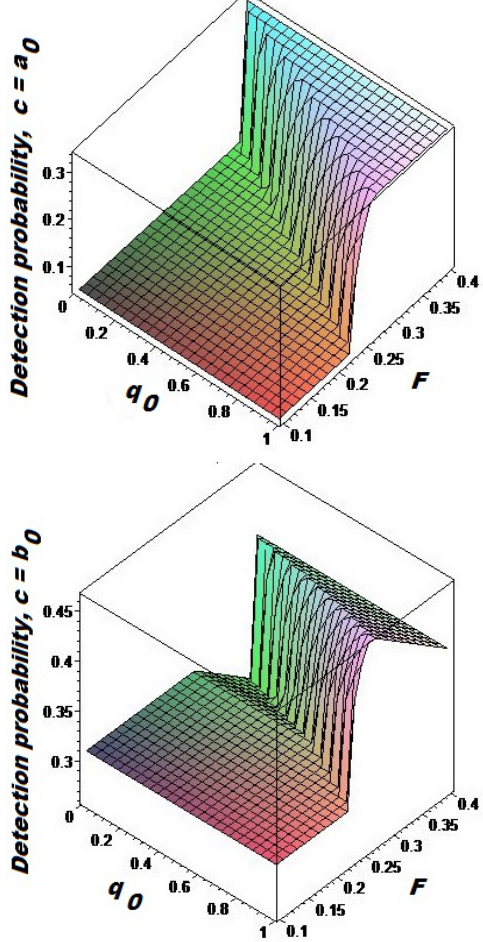
Figure 4. Detection probability of the Invader with c = a (upper) and c = b (bottom). Figure 5. Payoff (upper) and detection probability (bottom) of 0